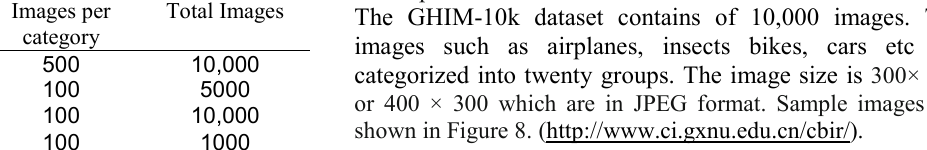
Figure 7. Sample Images of Corel-10k database Description of GHIM-10K